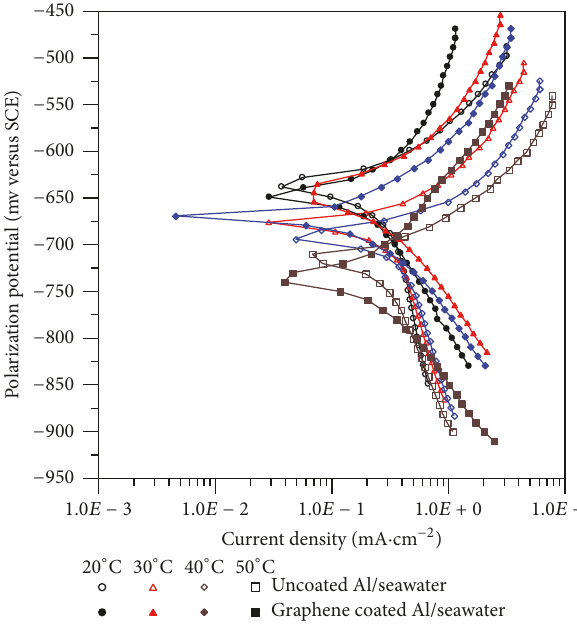
Figure10:TafelplotsofSS316specimensinseawatersystemwithout and with reduced GO coating at different temperature.